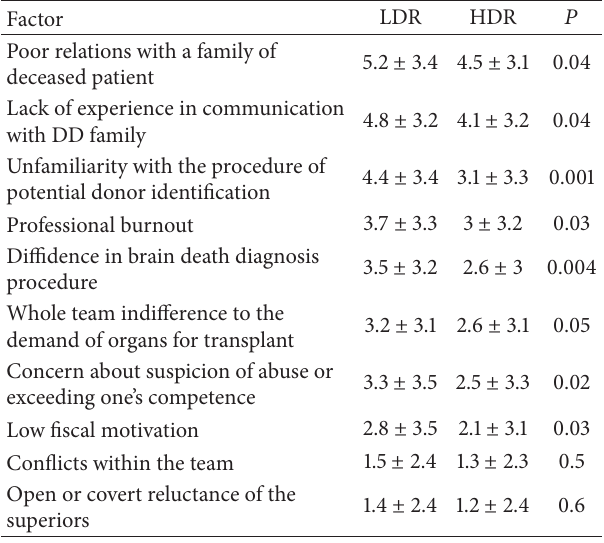
Table 2: Obstacles in identification of potential deceased donor according to 587 interviewed physicians ∗